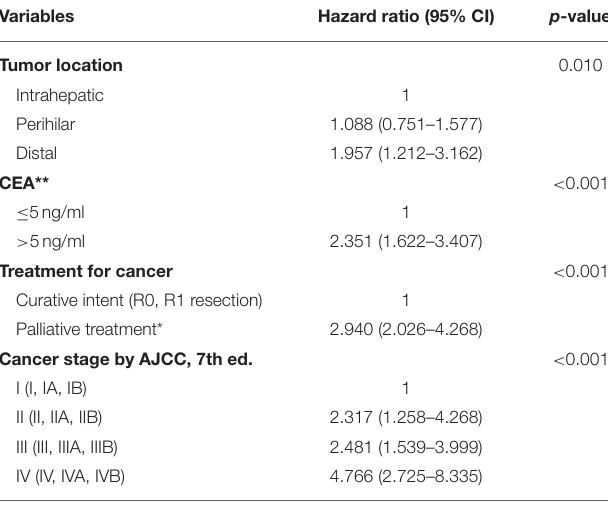
TABLE 3 | Univariate analyses of prognostic factors associated with overall survival in 367 cholangiocarcinoma patients. Variables